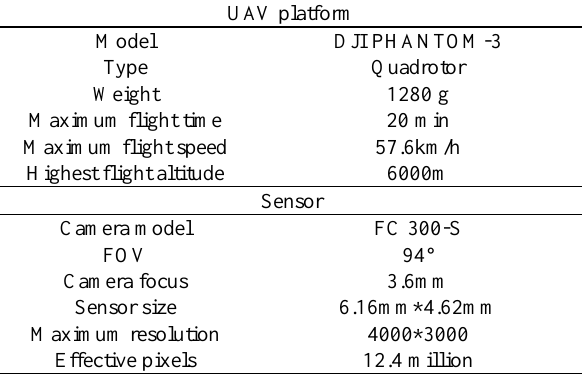
Table 1. UAV and sensor parameters